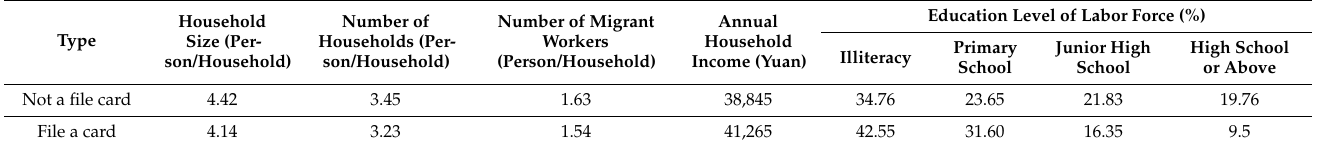
Figure 2. Location of ecological resettlement area in Liujiaxia Reservoir Area. Table 6. The characteristics of